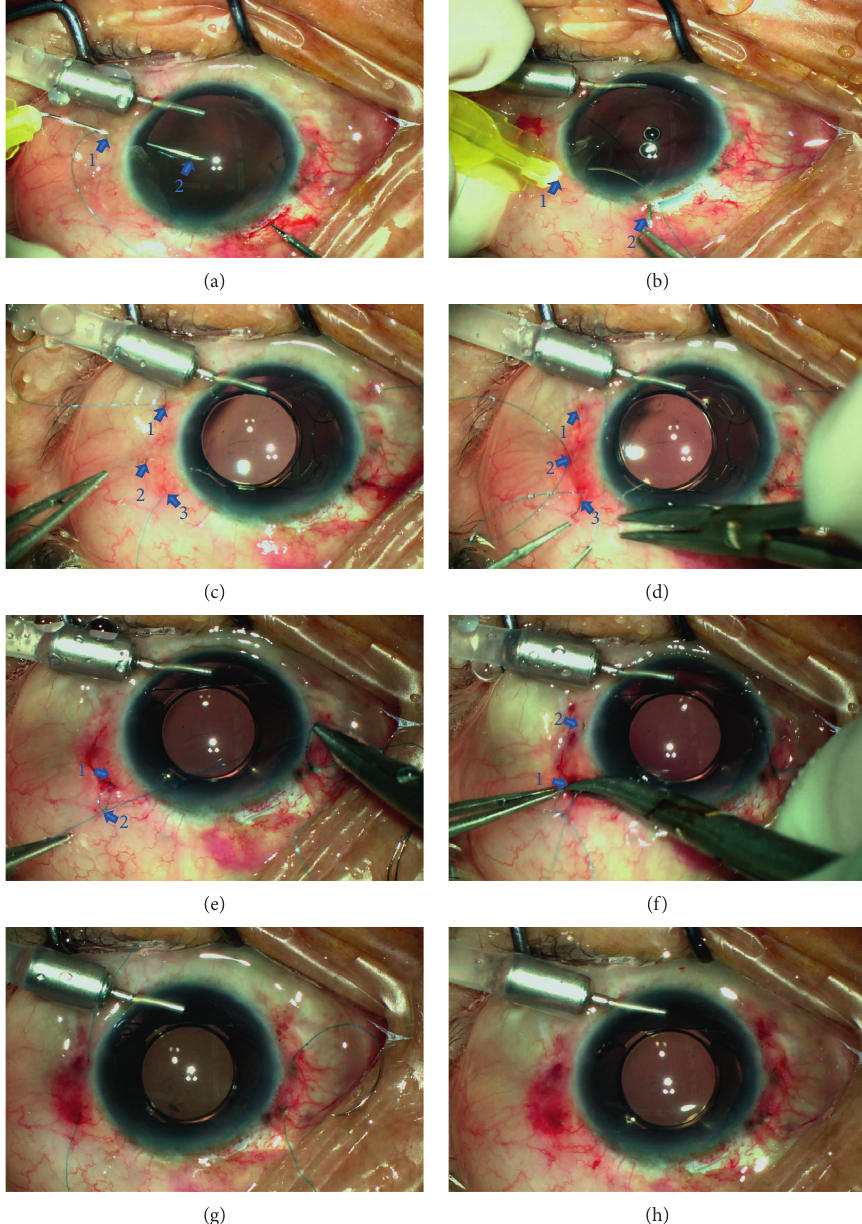
Figure 1: Intraoperative view of the surgical procedures. (a) Introduce the 8–0 polypropylene thread into the eye by the suture-in-needle technique using direct ab externo puncturing of a 30-gauge needle. Arrow 1: the first fixation point; arrow 2: the loop of the suture can be grasped by using forceps to retrieve it from the main incision. (b) After looping through the eyelets of the IOL, the thread is externalized by the curved-needle-retrieving technique. Arrow 1: the second fixation point; arrow 2: the tip of the curved 30-gauge needle. (c) After externalizing the four fixation sutures and implanting the IOL into the posterior chamber, the curved needle attached to the suture is held by a needle holder and intrascleral pass from the sclerotomy of the first fixation point (arrow 1) to the adjacent sclera (arrow 2) is performed. Arrow 3: the second fixation point. (d) Perform a relay intrascleral pass from the exit point (arrow 2) to exit the needle from the second sclerotomy (arrow 3). (e) Create the overhand fixation knot (arrow 1) by the two ends of the sutures to fixate the IOL. Create a second knot (arrow 2) 3mm from the exit point and perform the intrascleral incarceration of the knot. (f) Perform the intrascleral pass of the curved needle attached to thread and knots from the second fixation point (arrow 1) to the adjacent sclera (arrow 2). (g) After pulling the thread to lead the threads and knots into the scleral tunnel, only four threads remain from the sclera. (h) After cutting all the externalized threads flush to the sclera, the IOL is well centered. Conjunctival incisions are left